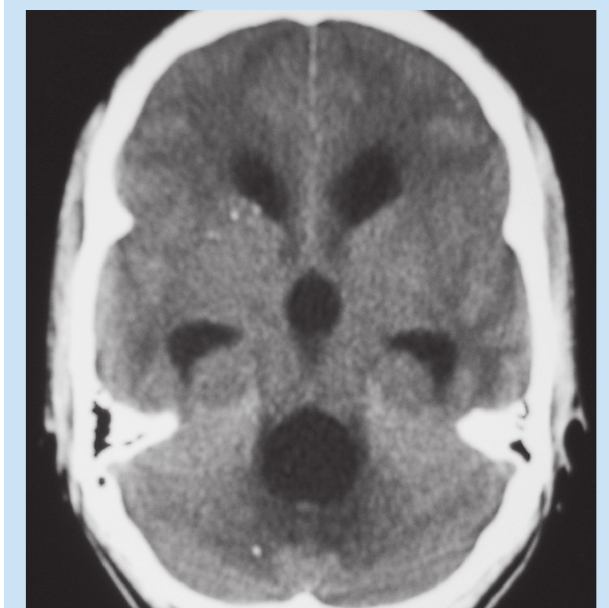
Fig. 1. Uncontrasted CT scan of the brain showing marked hydrocephalus, a disproportionately enlarged 4th ventricle, loss of surface sulcal markings and compression of the basal cisterns. Multiple punctate calcified paren- chymal lesions are also present, consistent with old